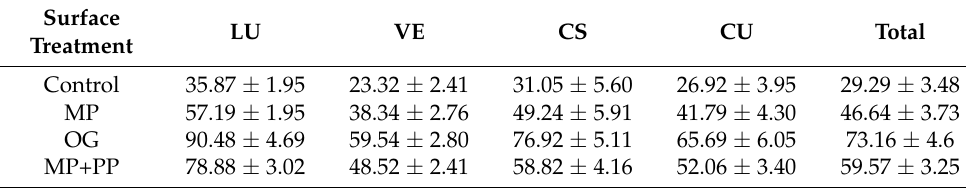
Table 6. Mean gloss (GU) of the surface-treated CAD/CAM ceramics.